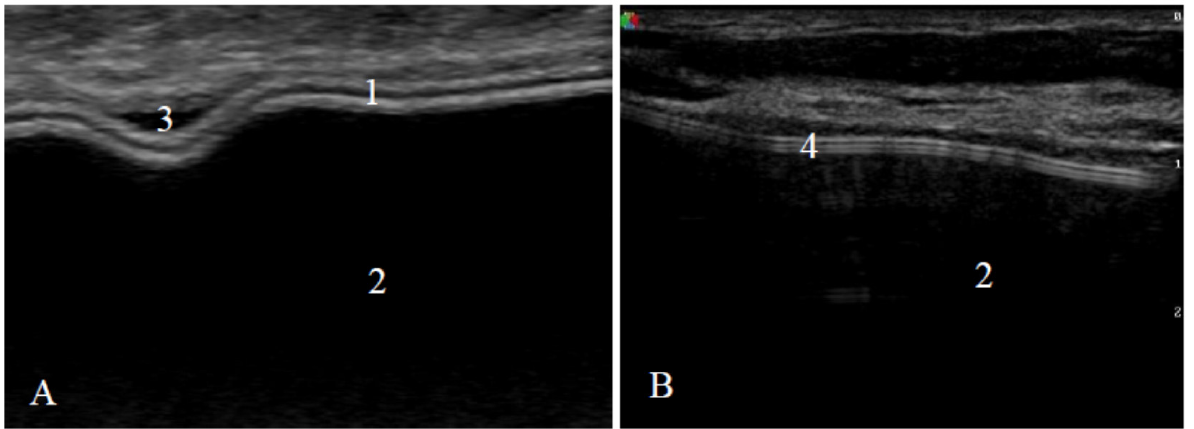
Figure 1. Signs of an intact implant on ultrasound: ( A ) a textured-surface implant (manufacturer Mentor) and ( B ) a smooth-surface implant (manufacturer Motiva); 1—shell (two parallel white lines); 2—homogeneous content; 3—implant shell wrinkle with small amount of peri-implant fluid; 4—shell (three parallel white lines). The signs of a ruptured breast implant were an uneven implant shell and inhomoge- neous intracapsular echotexture (Figure 2).